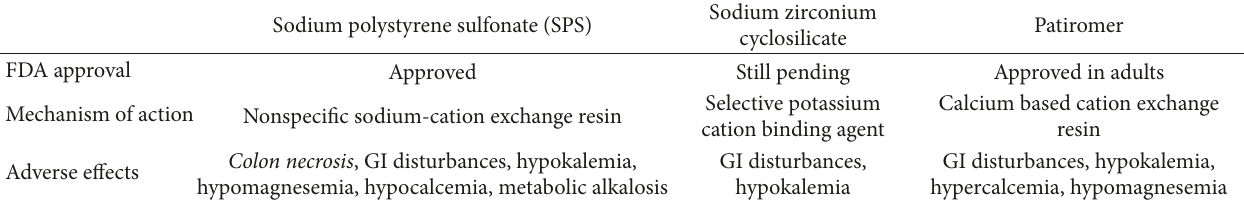
Table 1: Potassium sparing agents for management of hyperkalemia